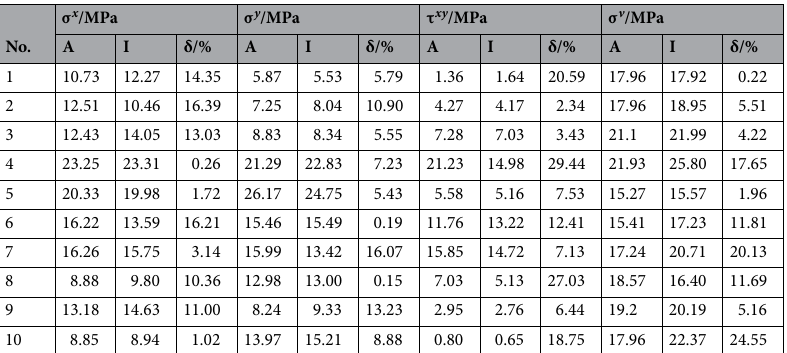
Table 2. Comparison between calculated and measured in-situ stresses based on transverse isotropy. A, I and δ represent the actual measured value, the inversion value and the relative error.